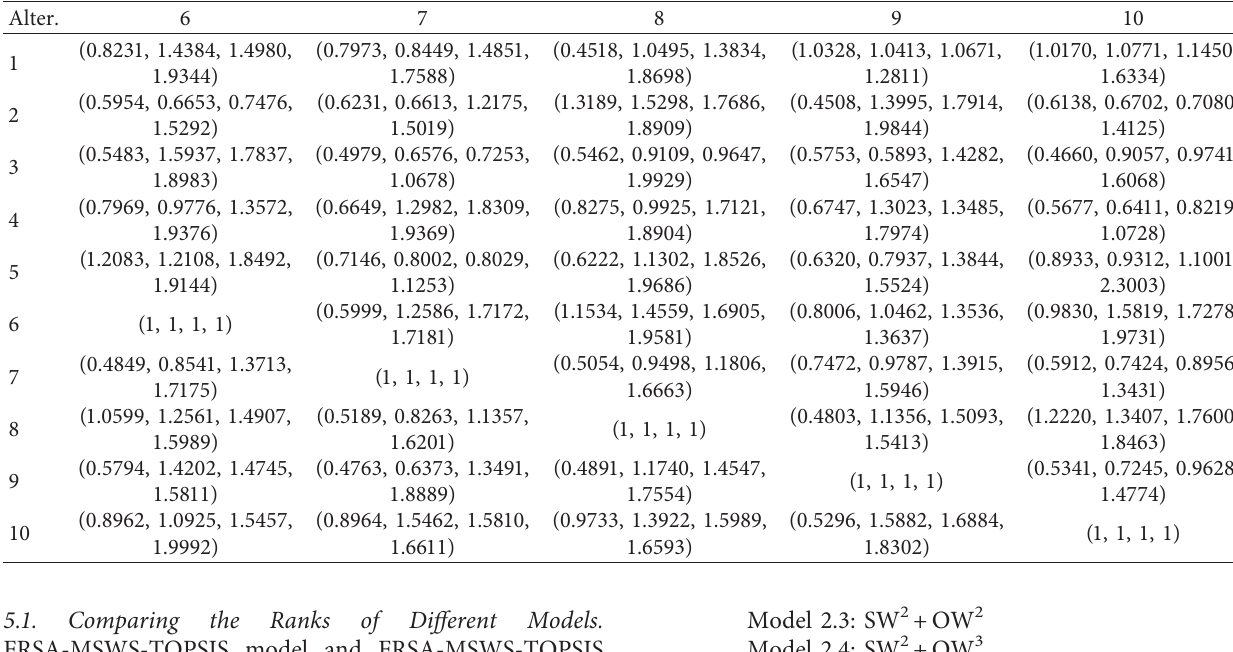
(part 2: columns LRL